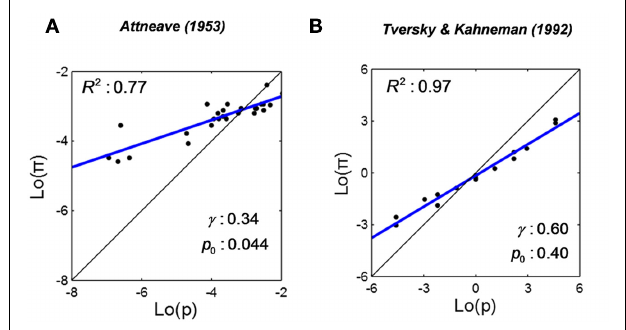
FIGURE 3 | Linear in log odds fits: frequency estimates. The two data sets in Figures 1A,B are re-plotted on log odds scales as (A,B) , respectively.The blue line is the best-fitting LLO fit. R 2 denotes the proportion of variance accounted by the fit.The S-shaped distortions of frequency/probability on linear scales in Figures 1A,B are well captured by the LLO